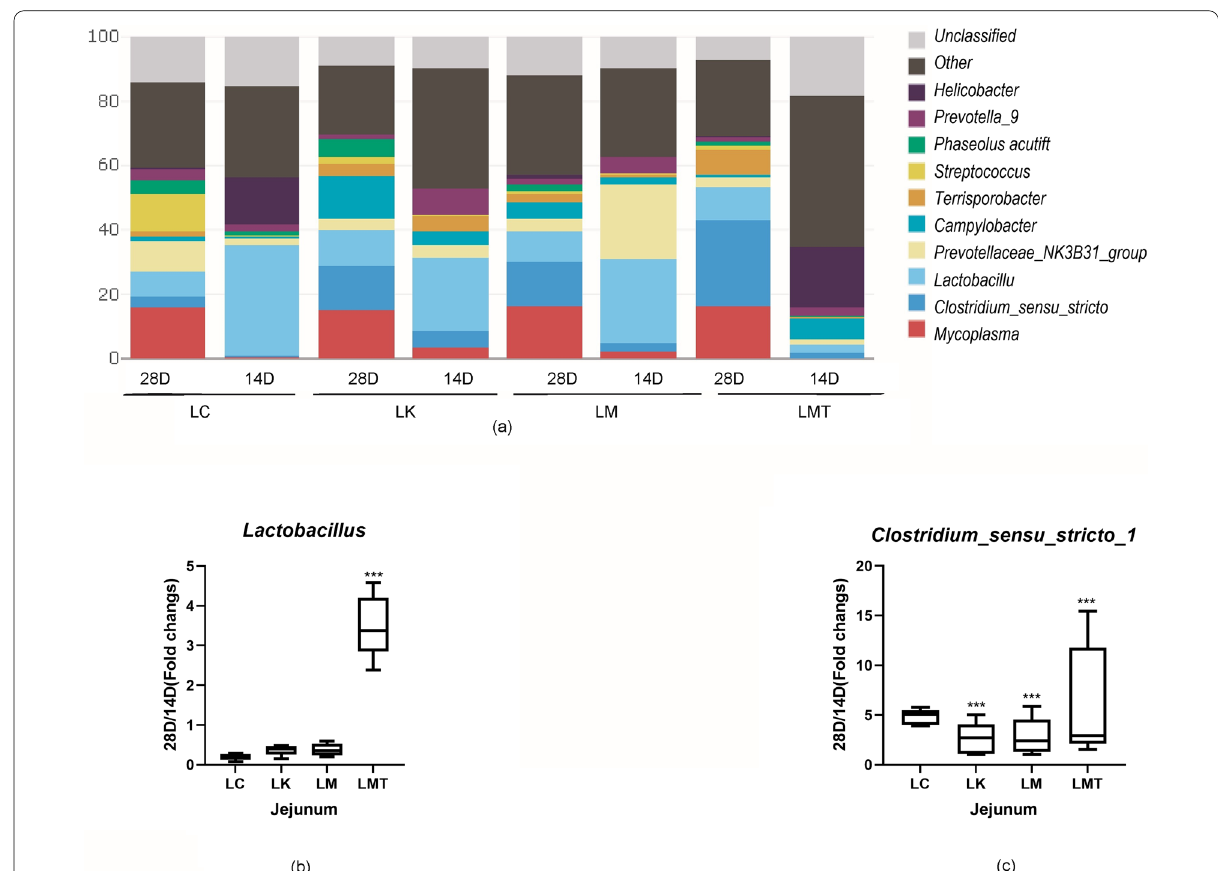
Fig. 9 Composition of the jejunum microbiota at genus and phylum levels. a The effect of the TCM formula on the composition of the jejunum microbiota at the genus level in the weaned piglets. b The fold change in the relative abundance of the genus Lactobacillus (28 d/14 d ratio). c The fold change in the abundance of the genus Clostridium sensu stricto 1 (28 d/14 d ratio) ( *P < 0.05; **P < 0.02; ***P < 0.01